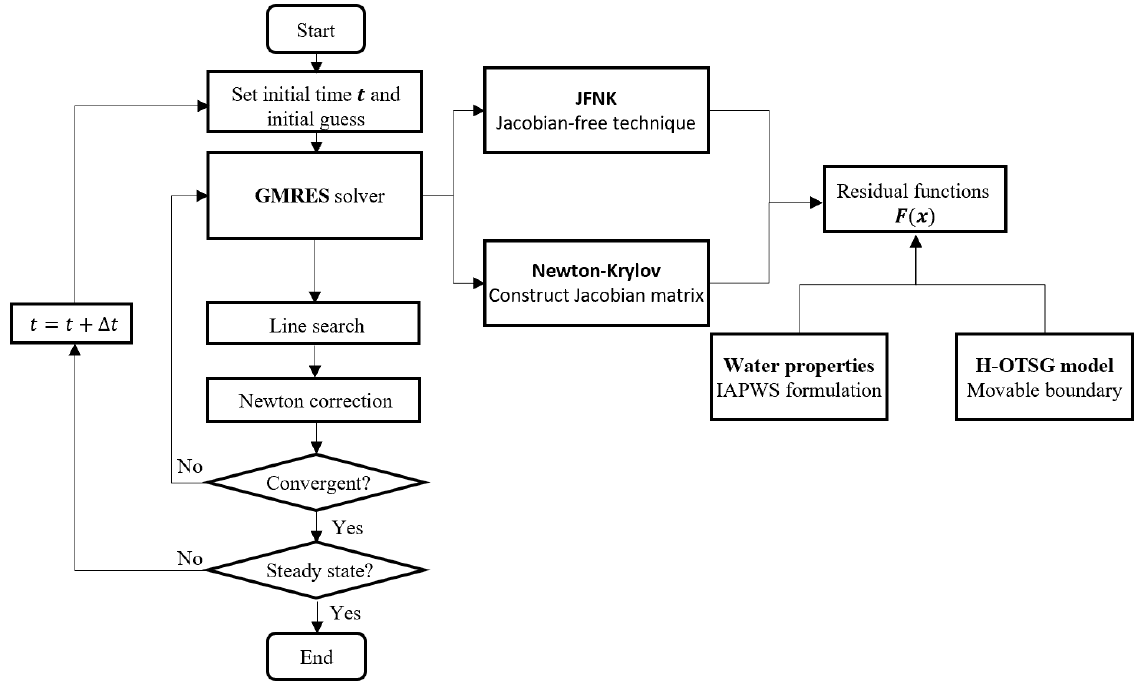
Figure 2. Flow chart of the fast simulation method for H-OTSG.